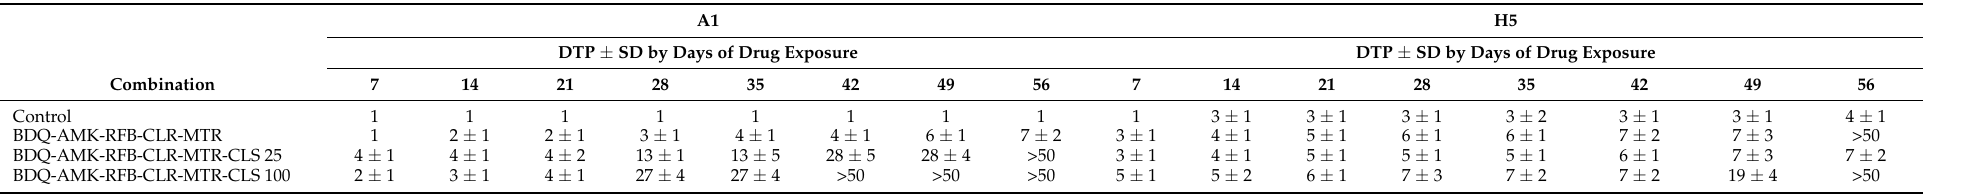
Table 2. Survival of A1 and H5 cells to various drug combinations, as estimated by regrowth in liquid medium using the MGIT 960 system. Day-to-positivity (DTP) values are indicated. Samples inoculated in MGIT 960 tubes refer to samples of Figure